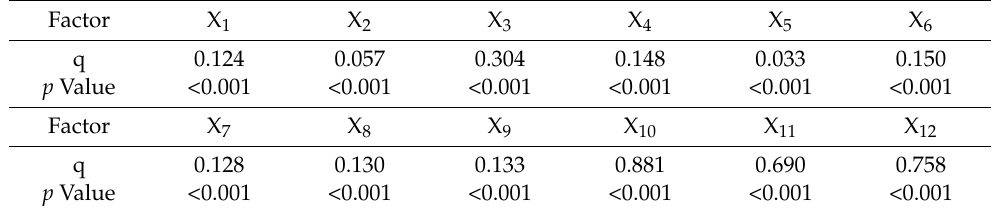
Table 3. Factor detection analysis results. (The meanings of different indicators are shown in Table